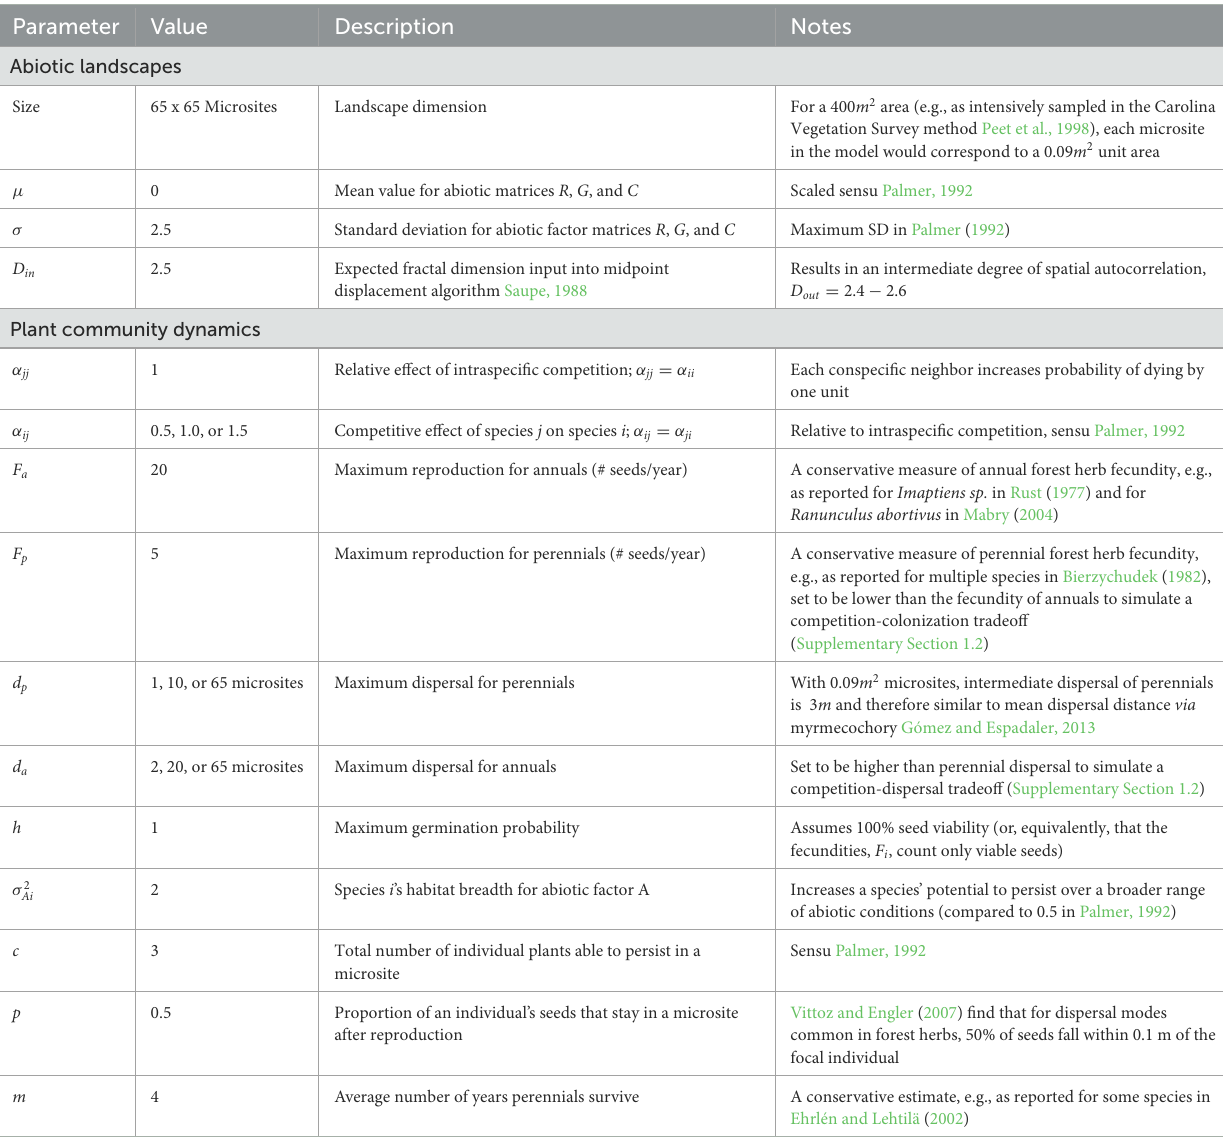
TABLE 1 Description of model